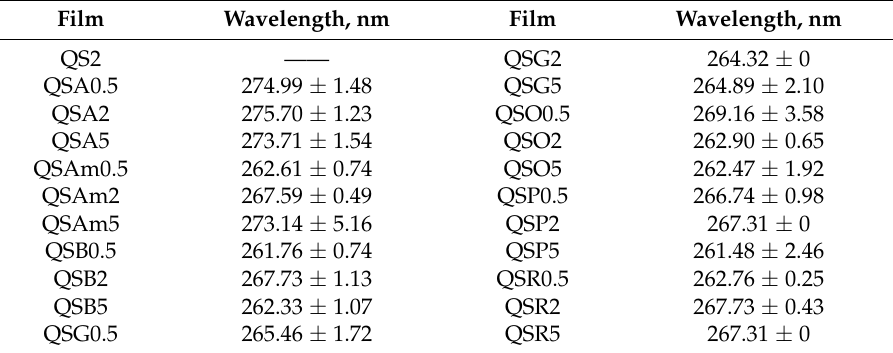
Table 3. Wavelength of antioxidant characteristic peaks for each film.